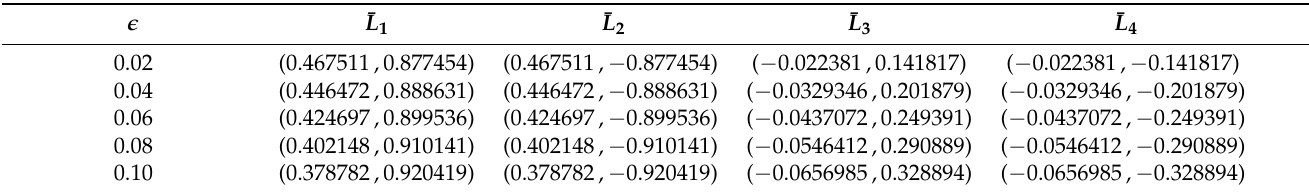
Table 3. Values of perturbed non-collinear Lagrangian points at different values of parameter (cid:101)